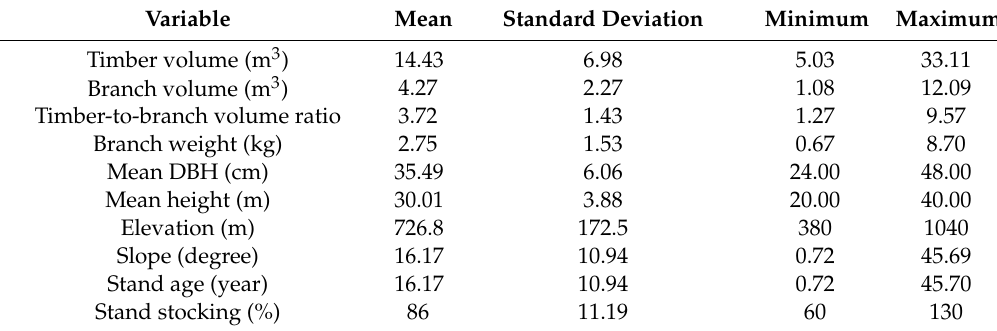
Table 1. Summary statistics of